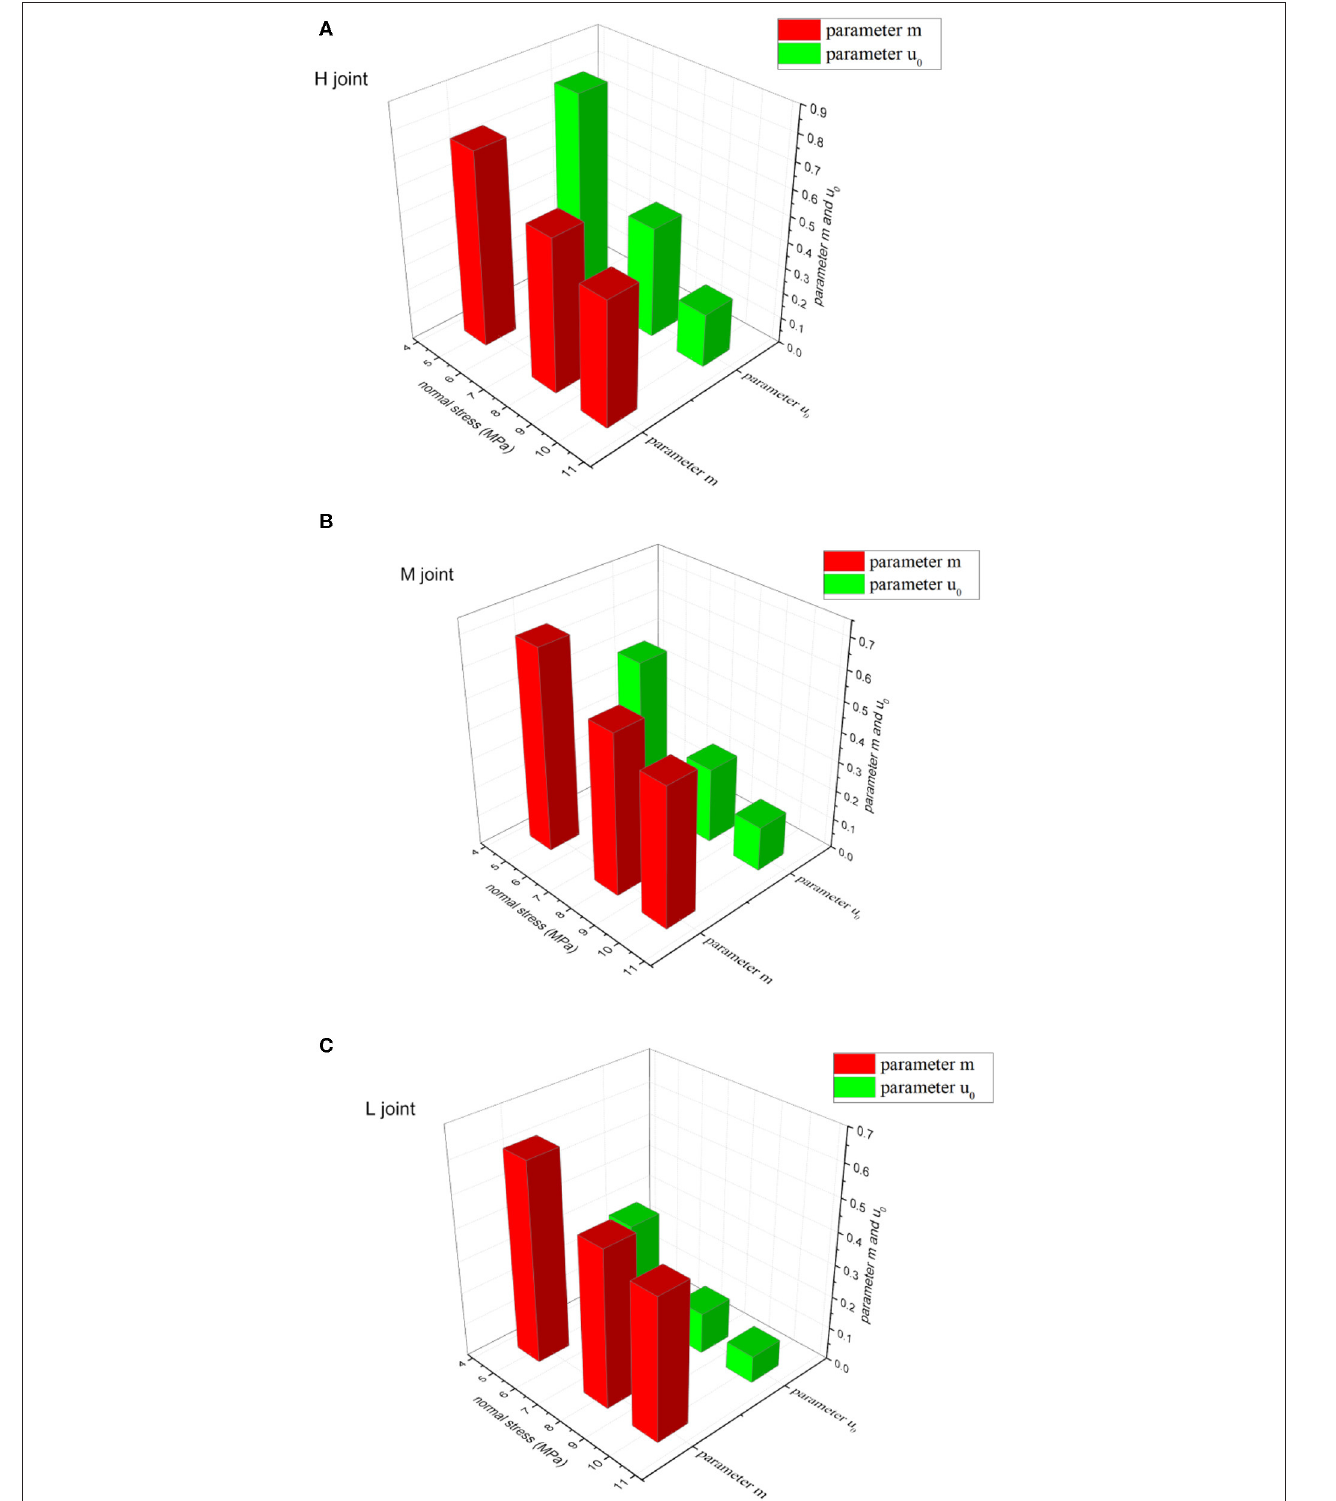
FIGURE 10 | The relationship between normal stress and model parameters m and u 0 . (A) H joint (B) M joint (C) L joint.